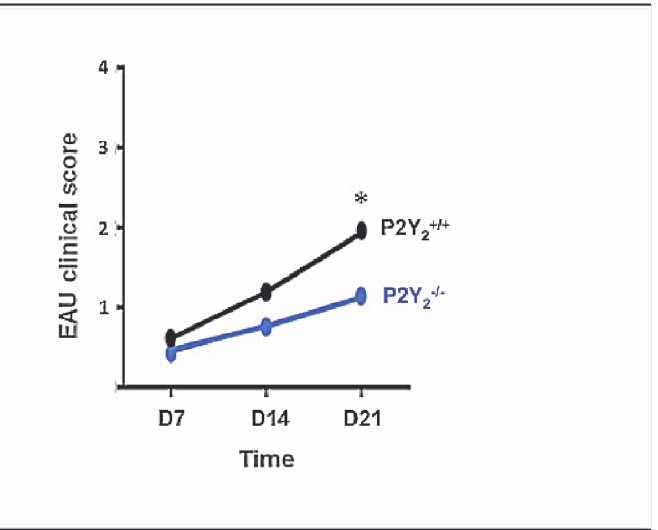
Fig 1. P2Y 2-/- mice are partially protected against uveitis development. EAU was induced in P2Y 2+/+ (n = 15 - > 12) and P2Y 2-/- (n = 15 - > 10) mice by s.c. immunization with IRBP 1 – 20 peptide emulsified in CFA and i.p. injection of PTX. A blind fundoscopy was performed at days 7, 14 and 21 to detect vitritis, optic neuropathy, vasculitis and retinitis. Data represent the median of EAU clinical scores established for all mice at each time point, in the two groups. Three independent experiments were done, starting with 5 animals in each group. * p < 0,05.